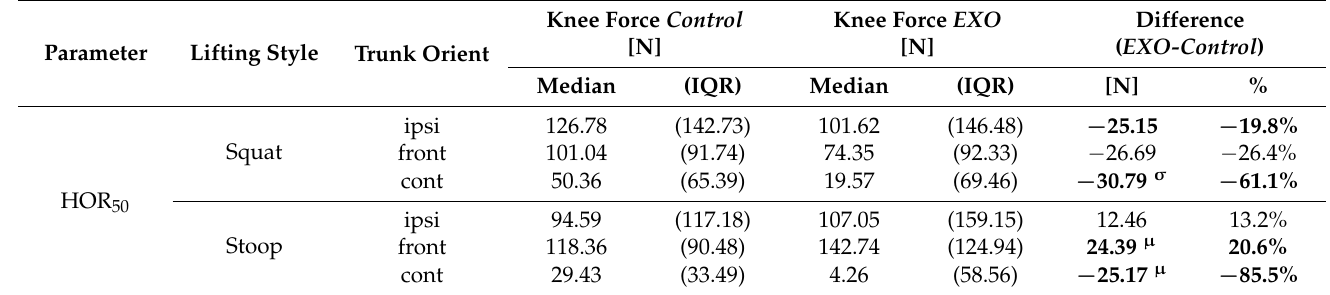
Table 3. Median knee force values and corresponding interquartile ranges (IQR), absolute and relative differences showing EXO compared to Control for the dynamic work task (three-fold interactions EXO × Trunk orientation × Lifting style